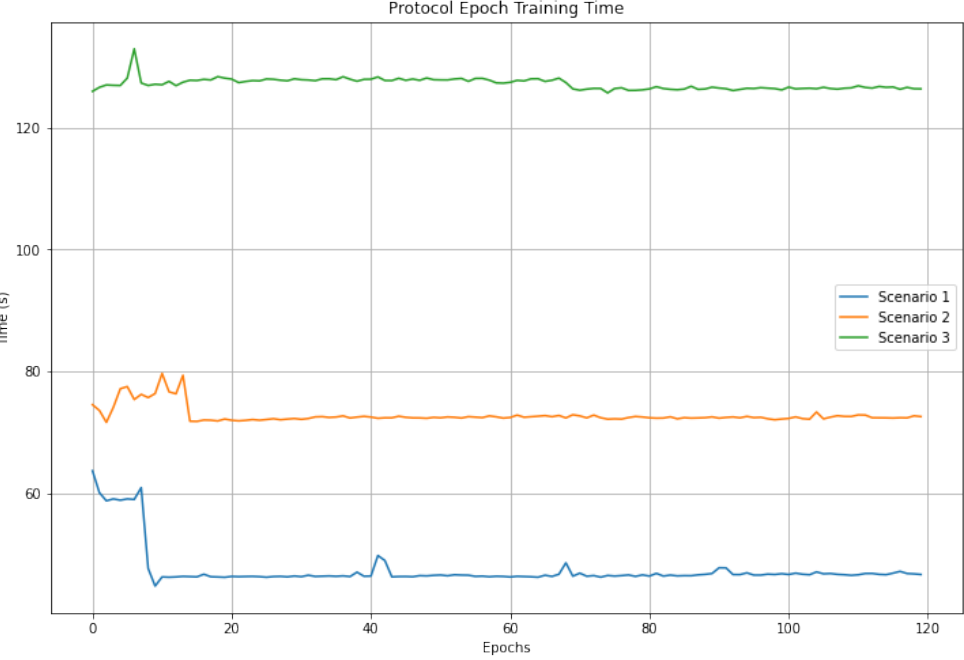
Figure 12. Comparison of training times by epoch using the training protocol.